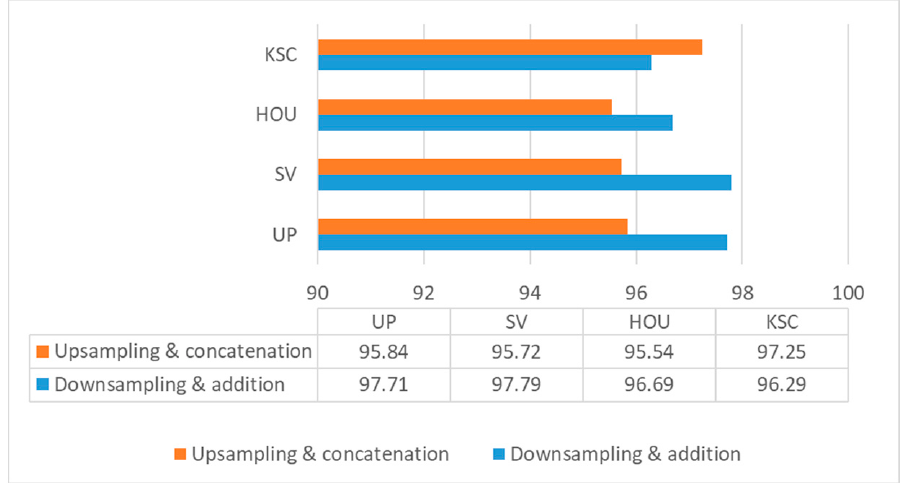
Figure 16. OAs (%) under different output heads in the HRM.